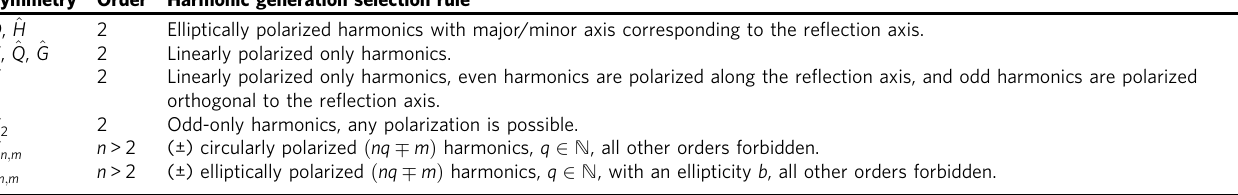
Table 1 (2 + 1)D DSs and their associated selection rules for collinear atomic/molecular HG Symmetry Order Harmonic generation selection rule ^ D , ^ H